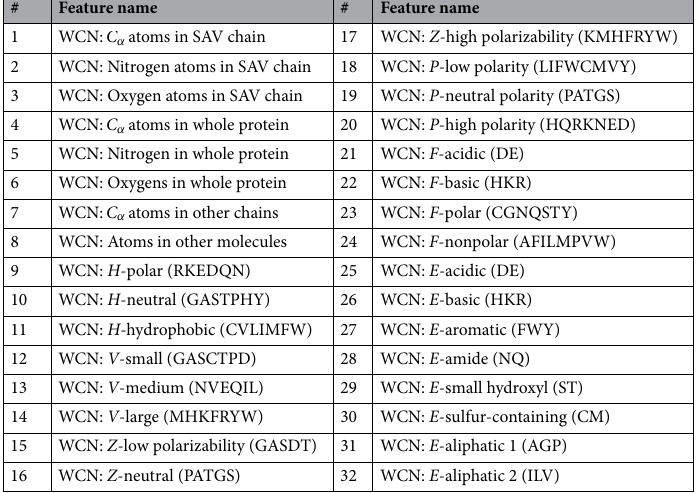
Table 4. List of descriptors in the microenvironment-based feature set.